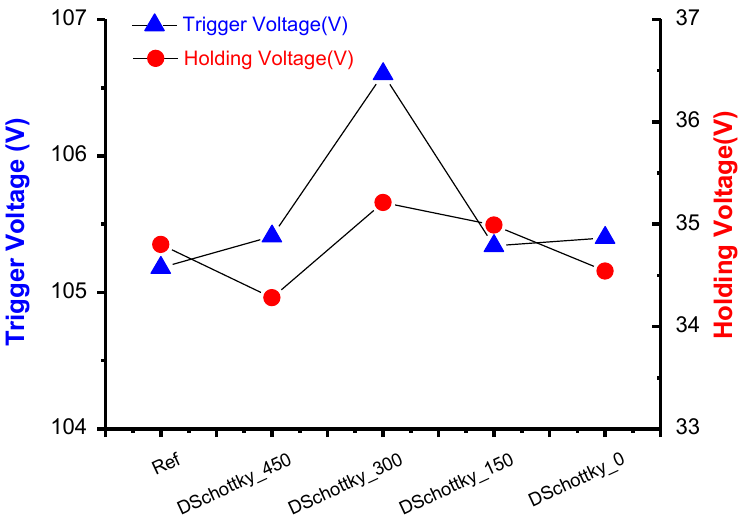
Figure 9. Trigger voltage and holding voltage distribution charts of HV nLDMOSs with the drain electrode-embedded horizontal Schottky length modulation.